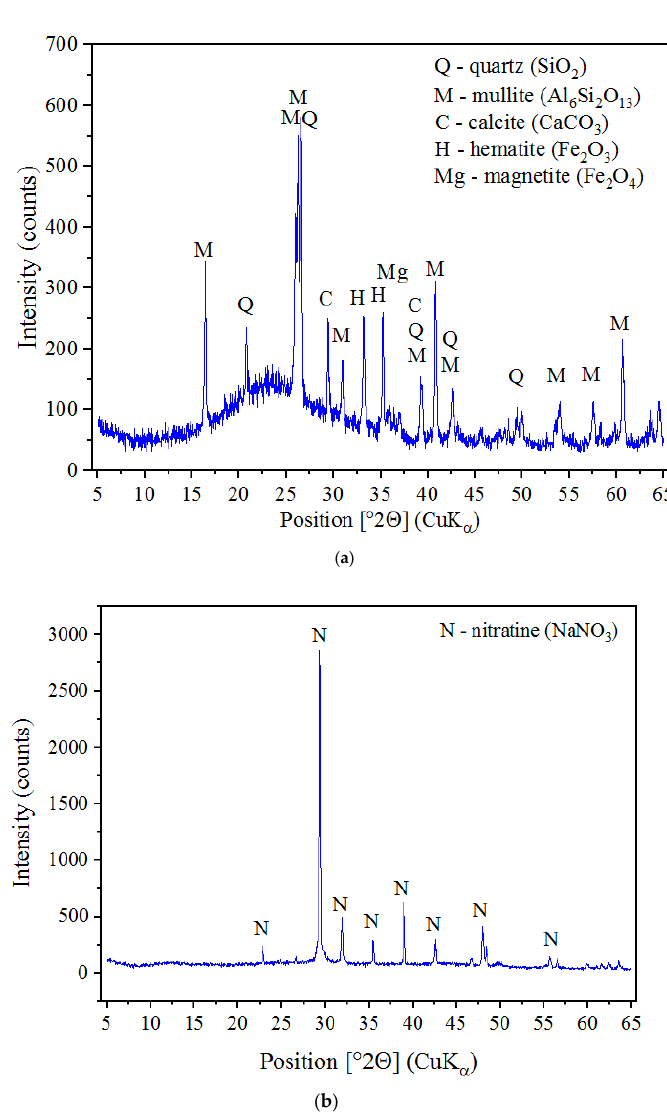
Figure 3. XRD patterns of the applied modifiers of cement matrix: ( a ) FA, ( b )